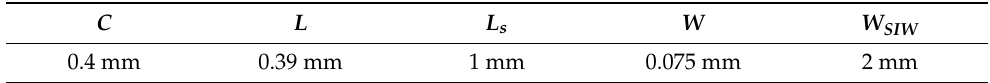
Table 1. The geometric parameters of the SSPPs unit